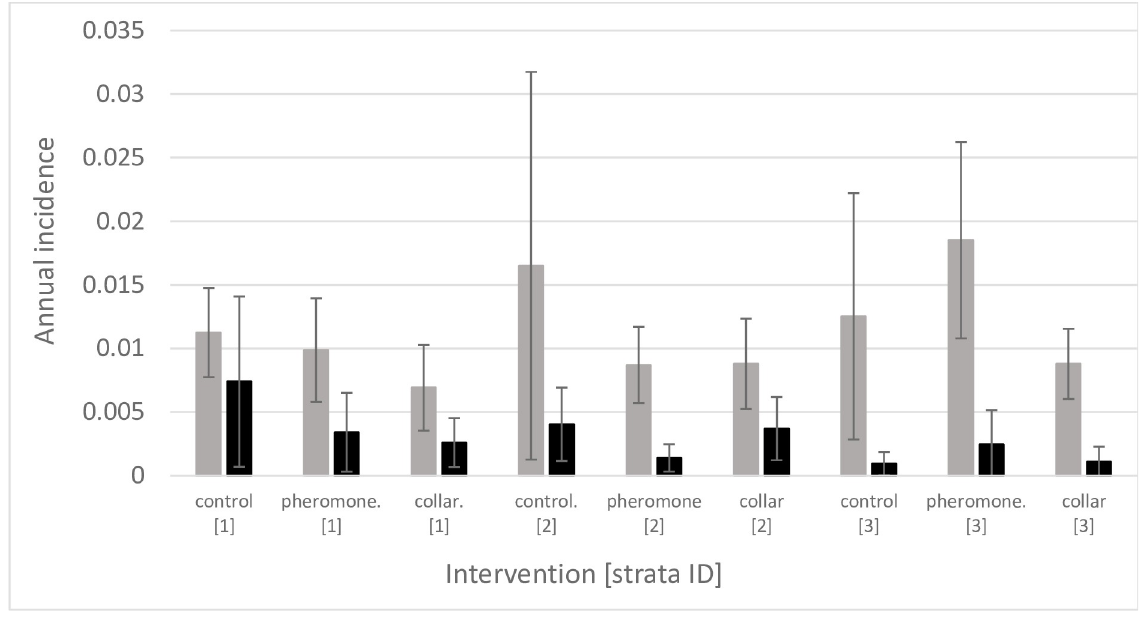
Fig 3. Mean annual incidence (+/- SD) of seroconversion (grey bars) and confirmed parasitological infection (black bars), between trial strata (ID’s 1 to 3) within control, pheromone and collar intervention arms.